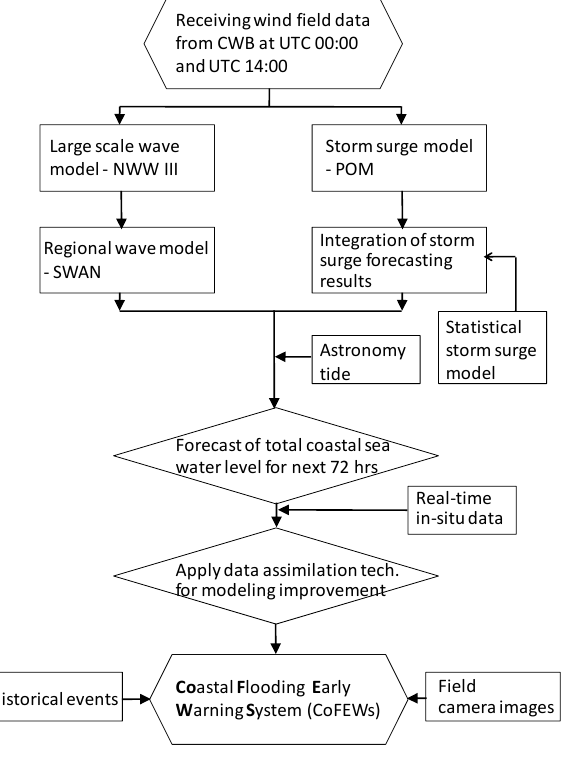
Figure 8 Flowchart of the operational models Fig. 8. Flowchart of the operational